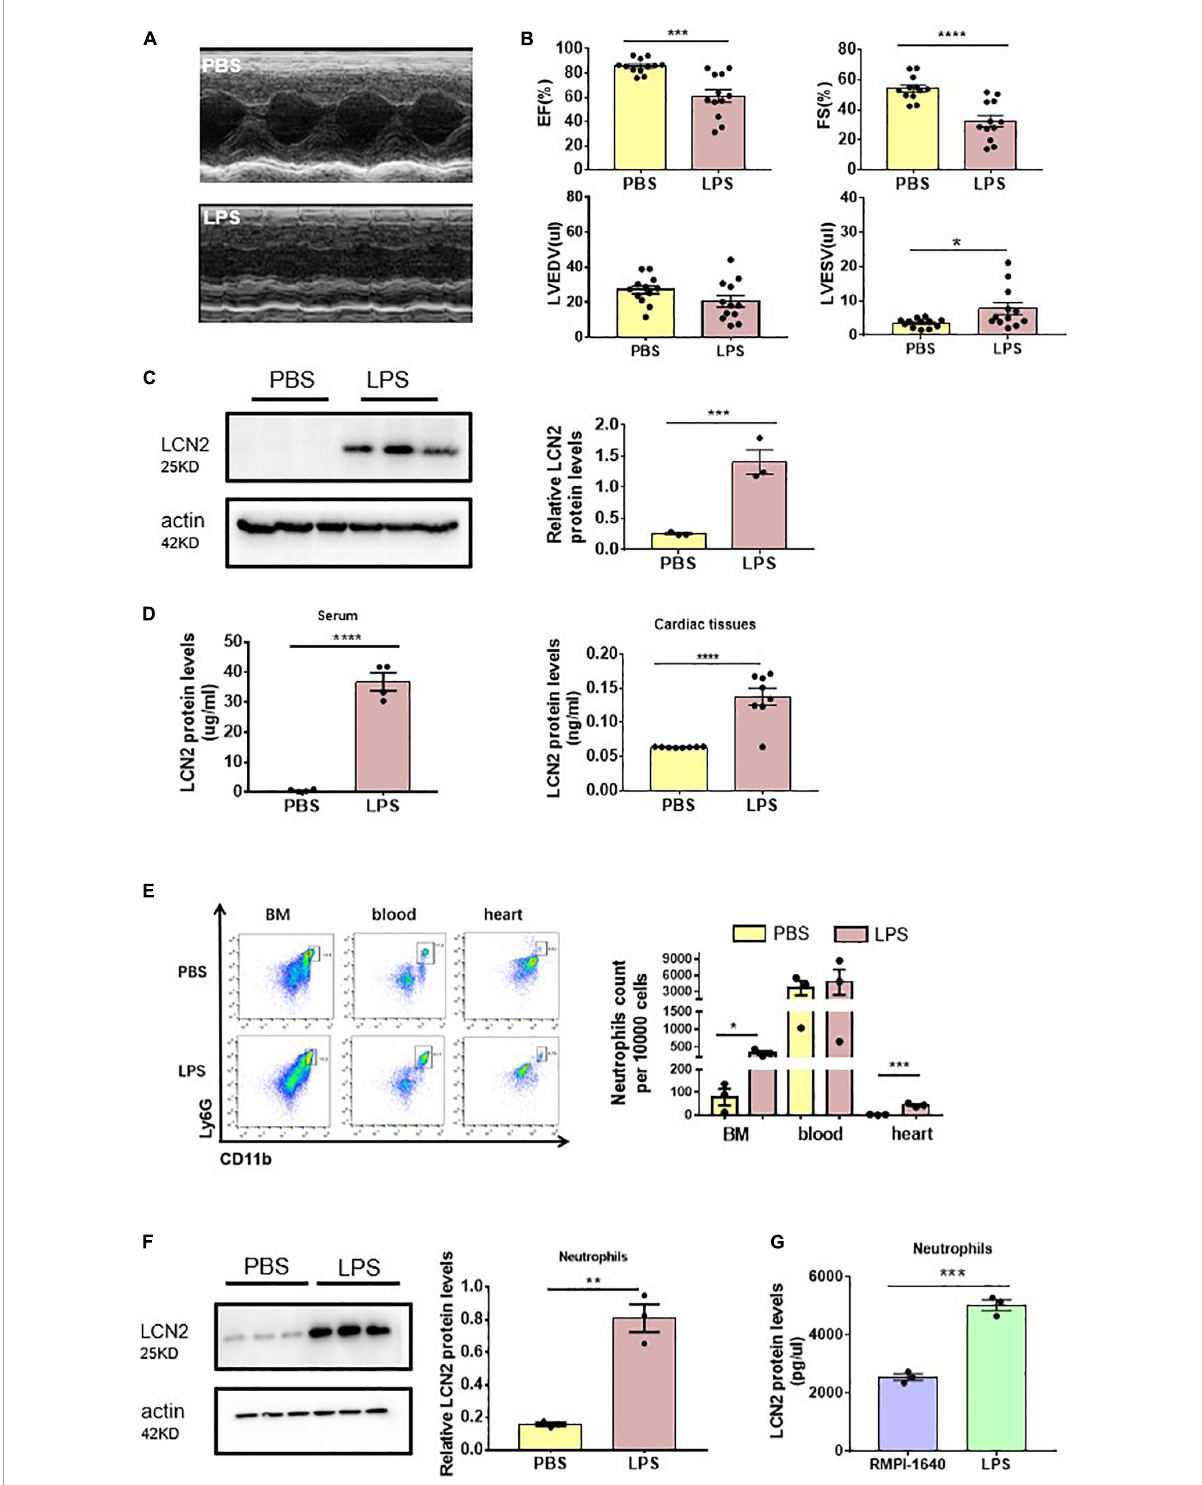
FIGURE1 Neutrophil-derived LCN2 was increased in LPS-induced SCD mice. (A,B) Echocardiography was performed 12 h after intraperitoneal injection of either PBS or LPS (25 mg/kg) in WT mice and their representative images ( n = 12 in each group). (C) Western blot was used to analyze LCN2 expressions in heart tissues 12 h after intraperitoneal injection with either PBS or LPS ( n = 3 in each group). (D) ELISA was performed to detect serum ( n = 4 in each group) and cardiac LCN2 protein levels ( n = 8 in each group) 12 h after intraperitoneal injection with either PBS or LPS